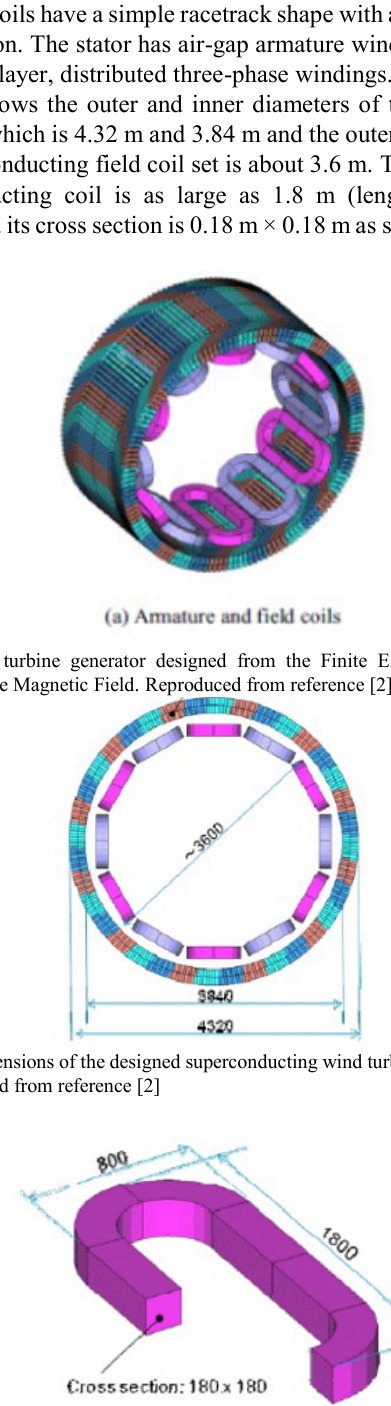
Fig.4 Superconducting racetrack coil for field magnets. Reproduced from reference[2]